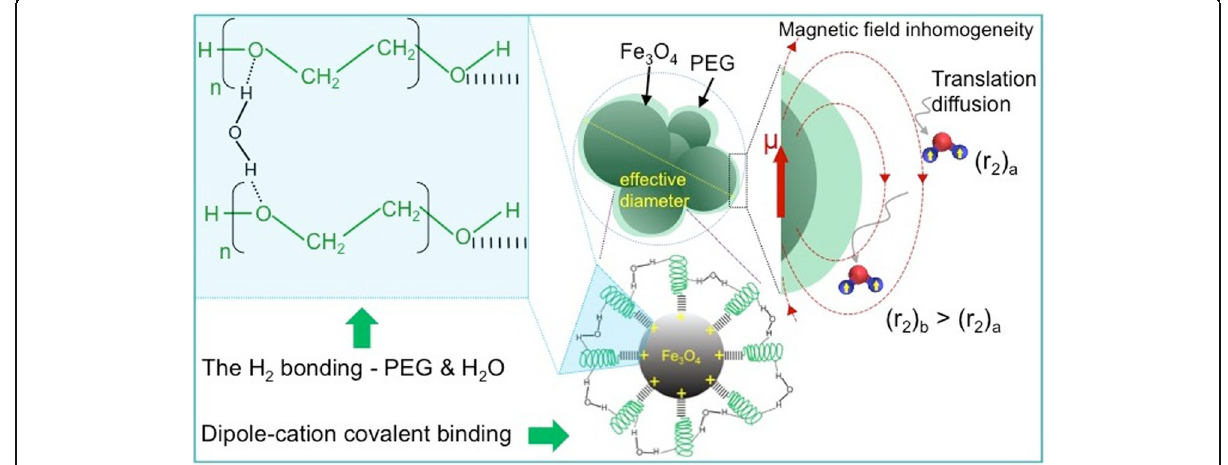
Fig. 11 Schematic illustration of the enhanced contrast mechanism of PEG-SPION